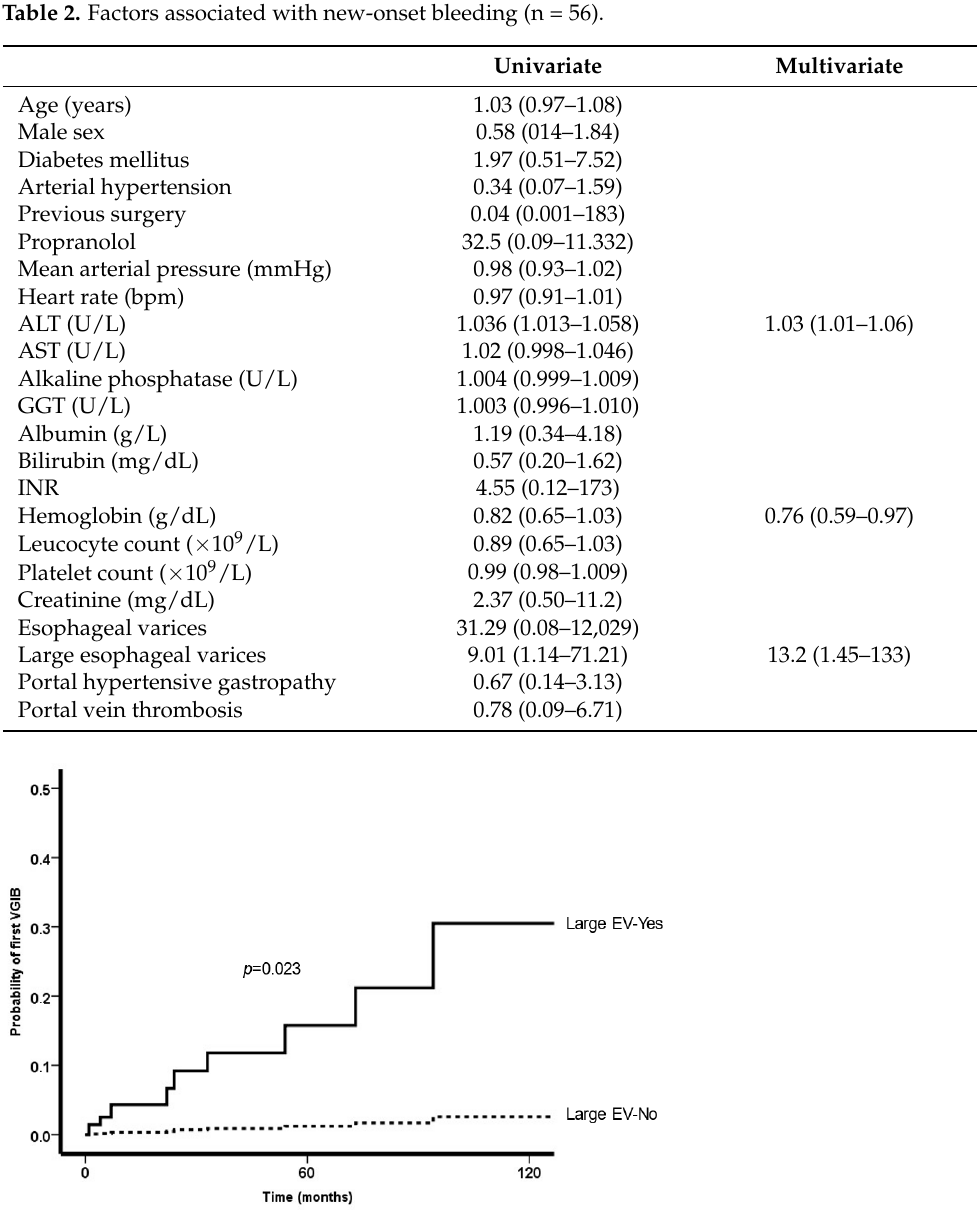
Figure 2. Probability of new-onset VGIB according to the presence of large esophageal varices (ad- justed by ALT and Hb levels).